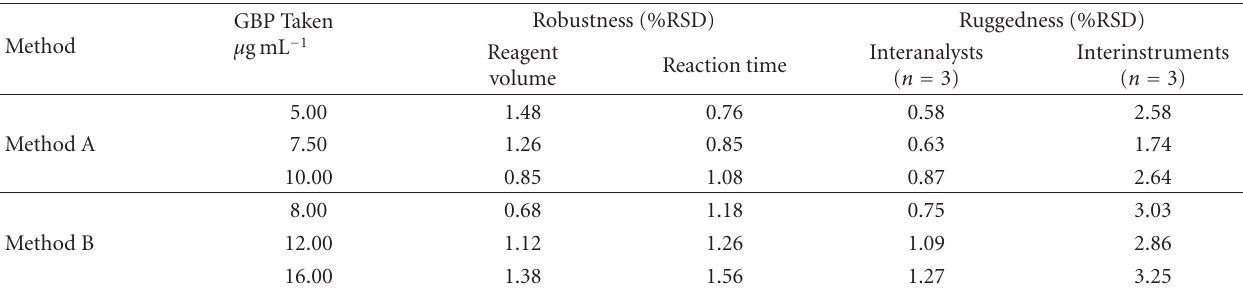
Table 6: Results of assay of capsules and statistical evaluation.